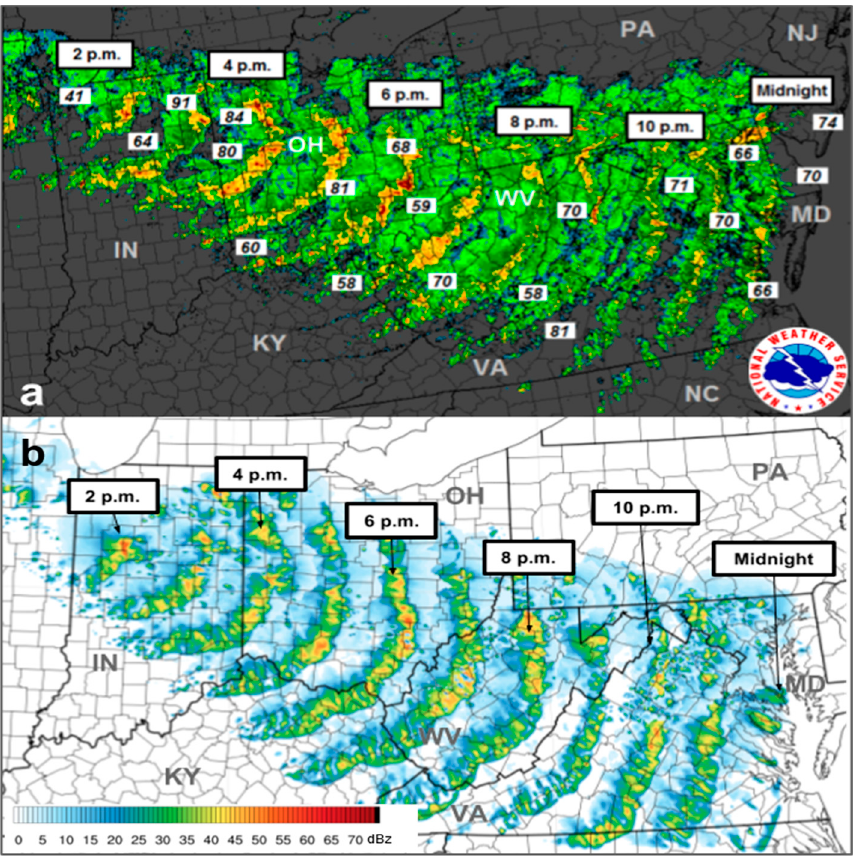
Figure 11. Comparison of 18Z 29 June through 04Z 30 June 2012 hourly ( a ) observed composite Doppler radar reflectivity (modified by Greg Carbon [19]) and ( b ) WRF-ARW 2-km simulated maximum reflectivity (dBz)